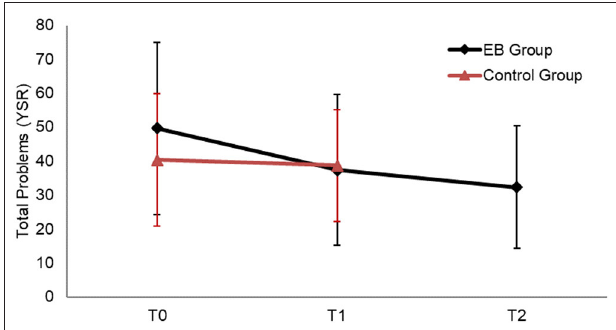
FIGURE 1 | Total emotional and behavioural problems at baseline (T0), after 12 months (T1), and after 24 months (T2) for experimental and control group.